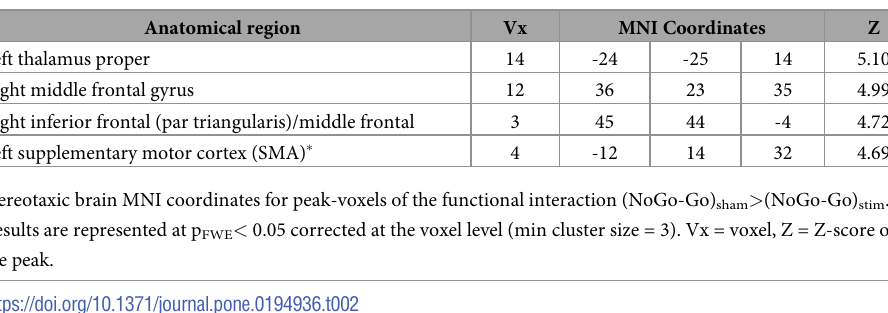
Table 2. Locations of clusters local maxima for the functional MRI interaction.